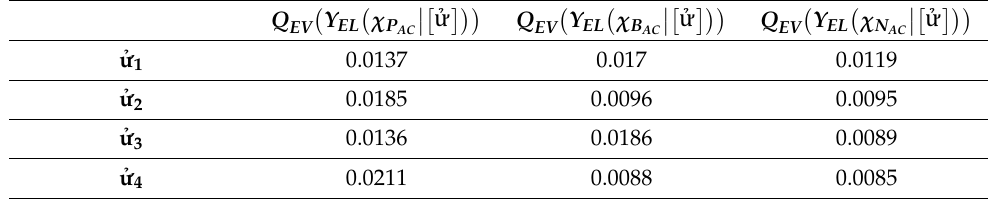
Table 6. Expected values from Table